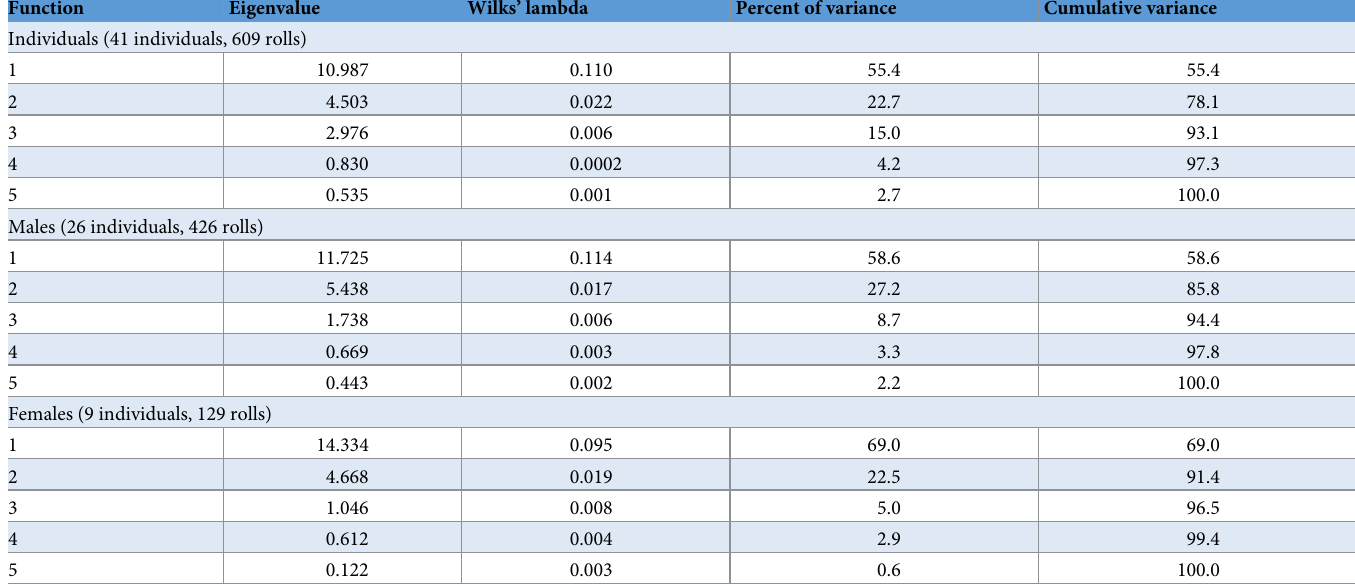
Eigenvalues, Wilks’ lambda, explanatory power are given.